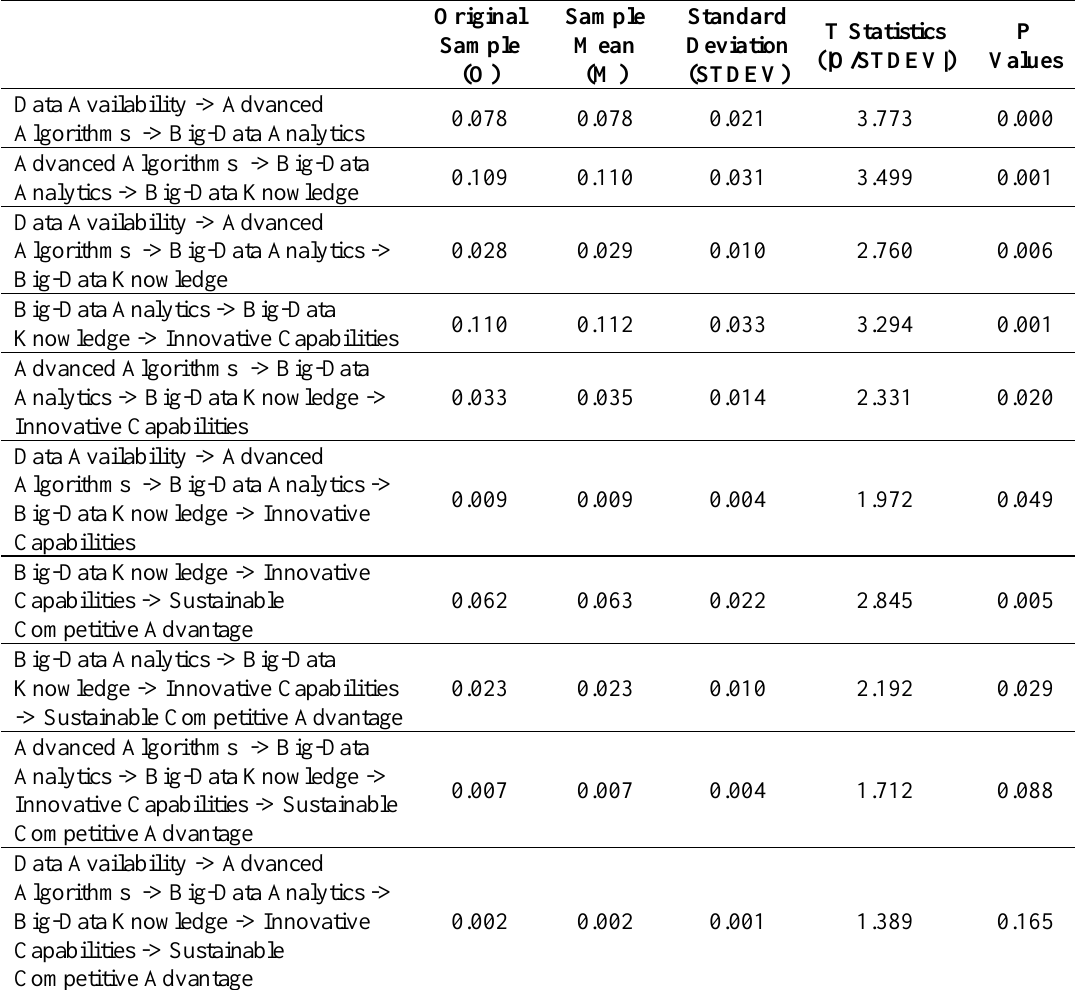
Table.6. Specific Indirect